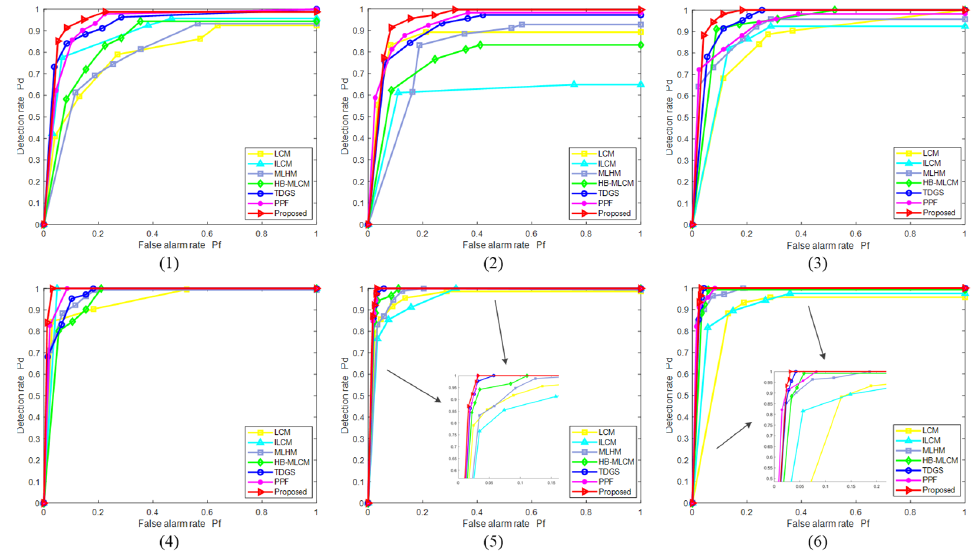
Figure 6. The comparisons of ROC curves.